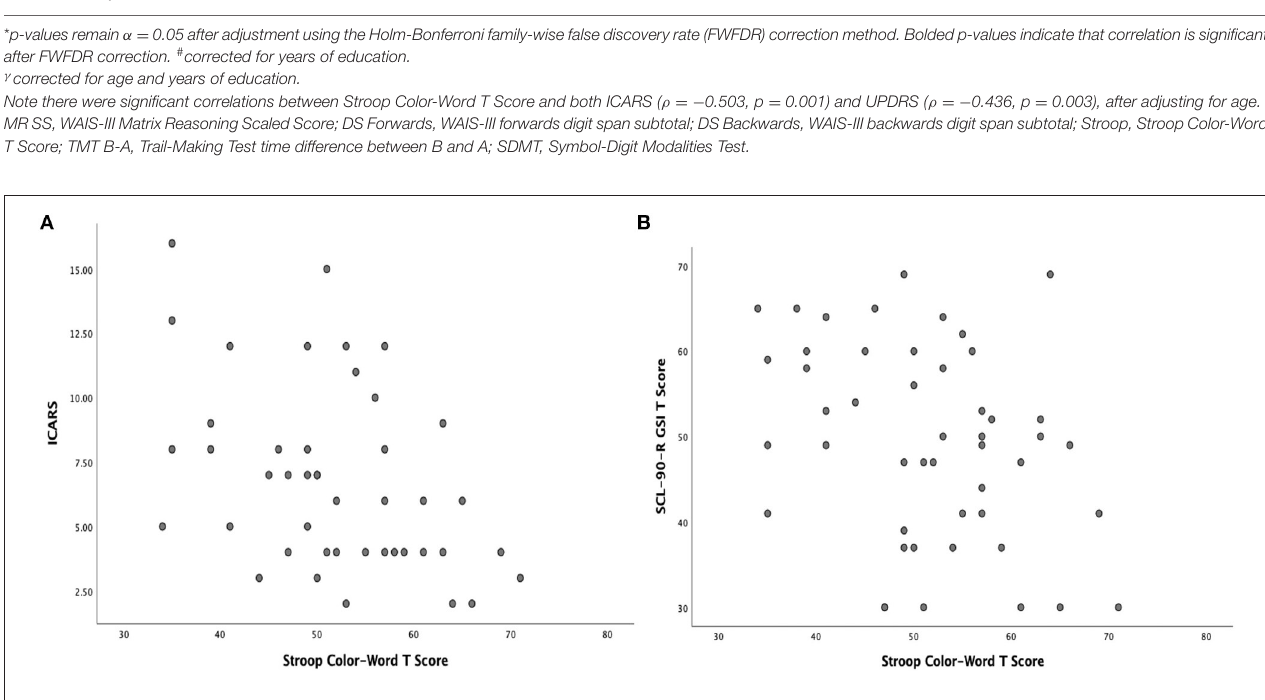
(psychiatric) manifestations—are interrelated at a subtle yet detectable level in female PM carriers. It is of special